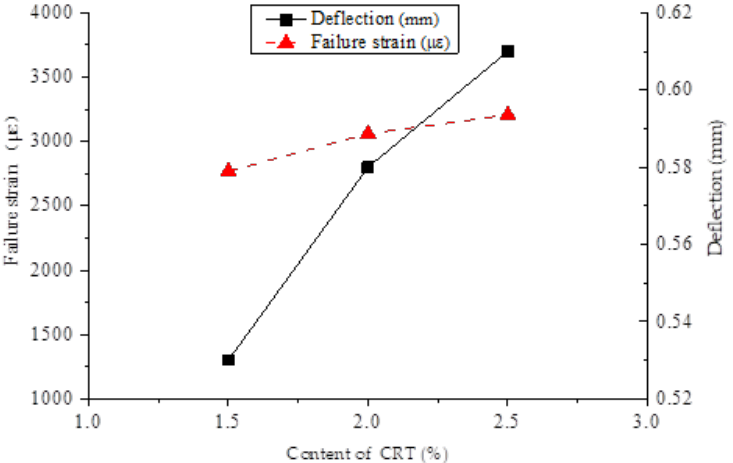
Figure 6. Results of low-temperature test.